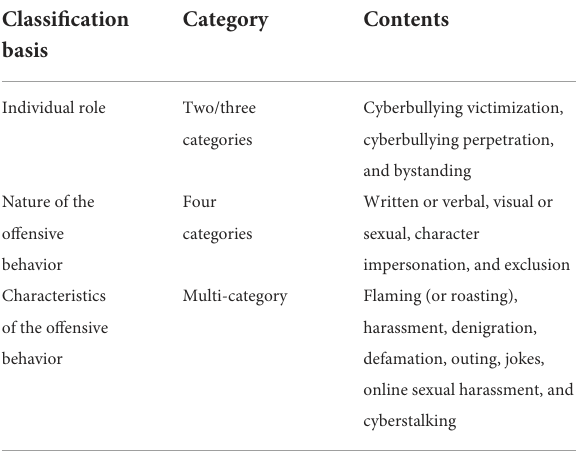
TABLE 4 The foundations for cyberbullying